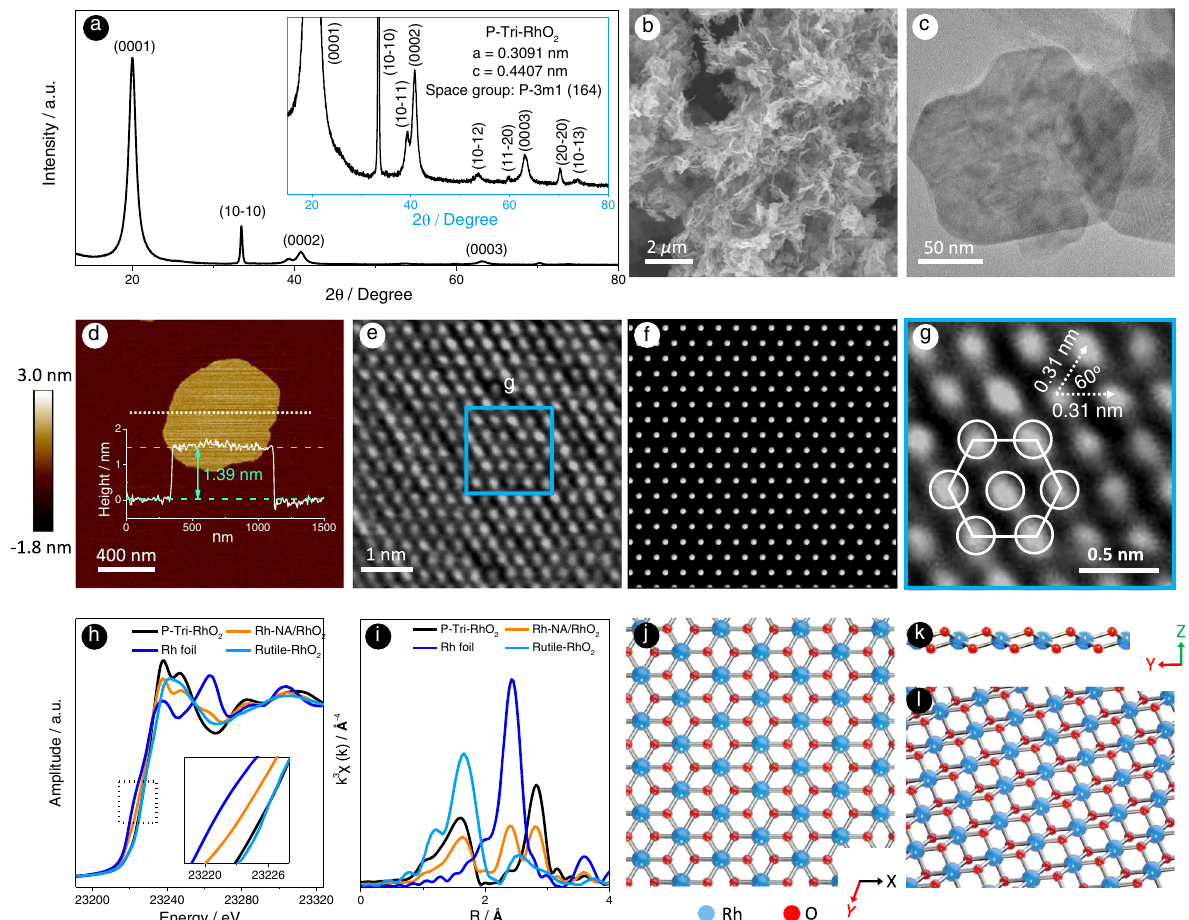
Fig.1|StructurecharacterizationofP-Tri-RhO 2 andRh-NA/RhO 2 .a XRDpattern and its enlarged view. b The SEM and ( c ) TEM images, showing its 2D nanosheets morphology. d AFM image and the corresponding height pro fi le. e STEM image, clearly showing the atomic arrangement of Rh. f Simulated STEM image and ( g ) partial enlargement from ( e ). h Normalized Rh K-edge XANES spectra for P-Tri-